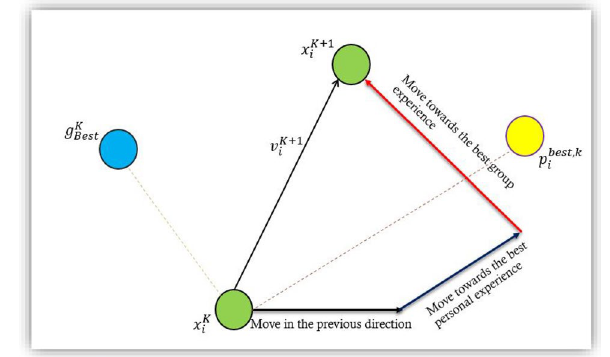
Fig. 3 Particle movement in one step of PSO